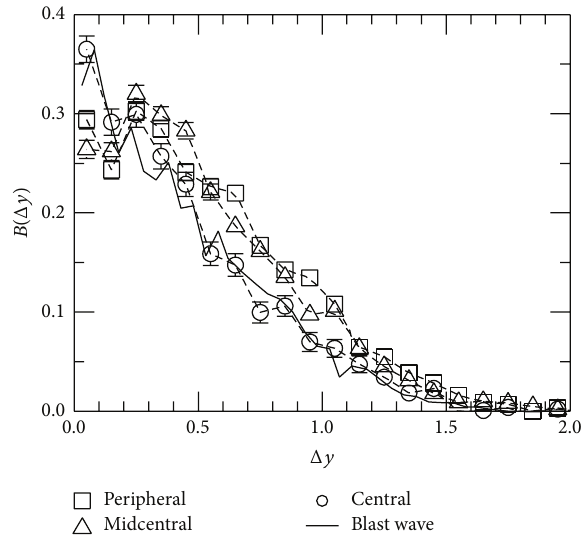
Figure 16: The balance functions for 𝜙 = 0 ∘ (in-plane), 𝜙 = 45 ∘ , and 𝜙 = 90 ∘ (out-of-plane) particles pairs. The 40–50% centrality bins are shown. The points are from the data (not corrected for event plane resolution), while solid lines represent the blast-wave model calculations. The graph is taken from [34].